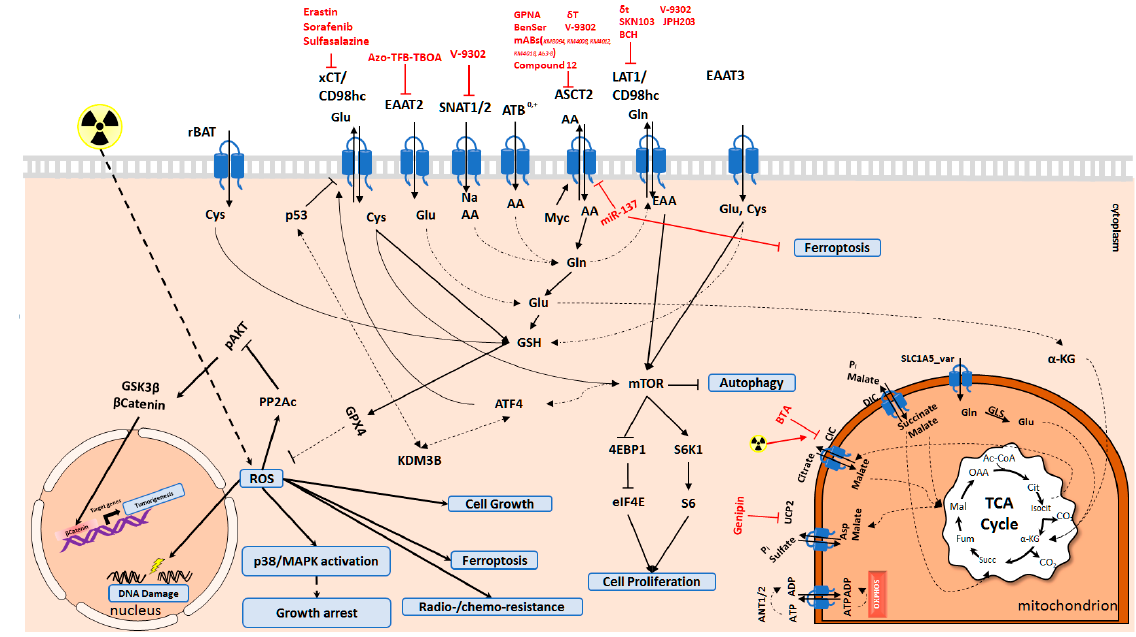
Figure 2. Molecular mechanisms activated by amino acid transporters. Amino acid transporters are vital to balance the intracellular amino acid pool for many cellular functions. Depending on the amino acid transporter activity, ferroptosis, apoptosis, autophagy, and proliferation of cells is regulated. Cys and Glu are the key amino acids for the synthesis of GSH. Cells deal with ROS species through GSH to decrease DNA damage, protein oxidation, and lipid peroxidation. GLS: Glutaminase; GSH: Glutathione; Cys: Cysteine; Glu: Glutamate; Gln: Glutamine; Asp: Aspartate; AA: Amino acids; EAA: Essential amino acids; α KG: alpha-ketoglutarate.